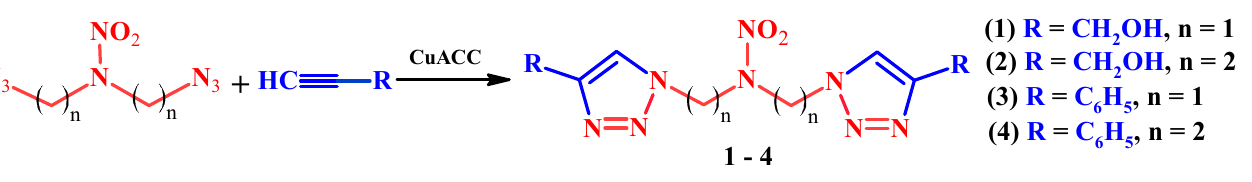
Figure 1. A general synthetic protocol for 1,4-substituted 1,2,3-triazoles.